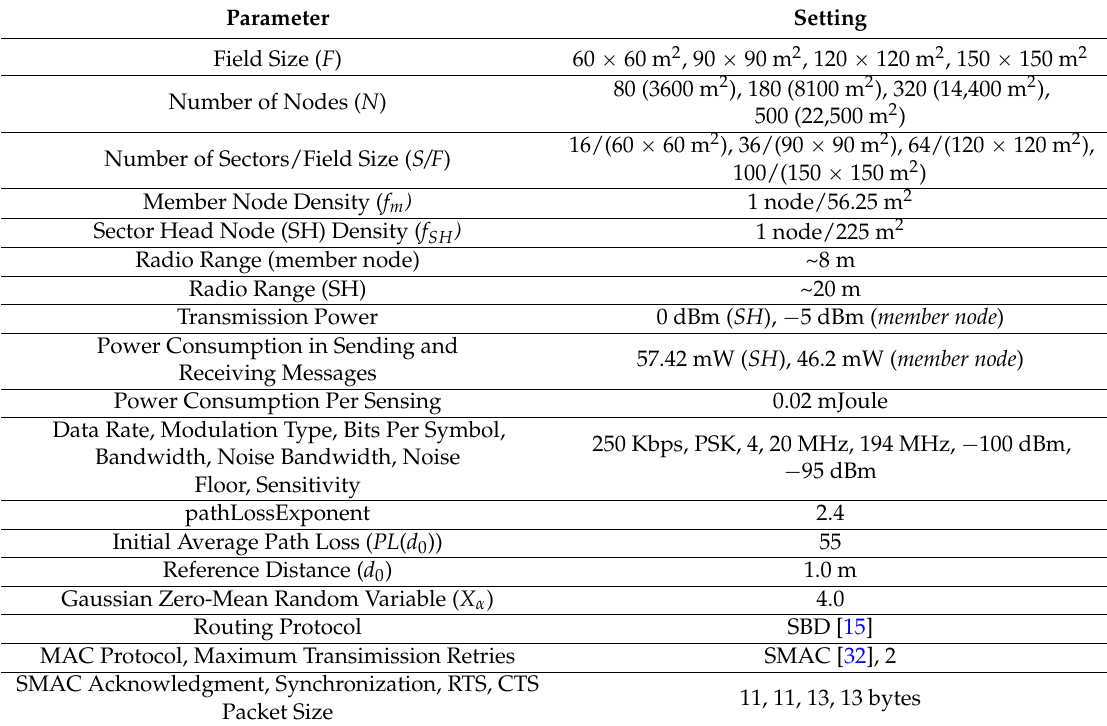
Table 4. Simulation